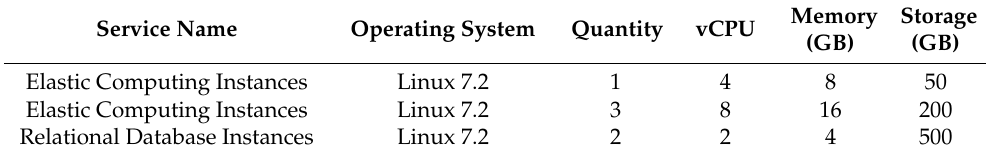
Table 7. Cloud resource list for Pattern I.